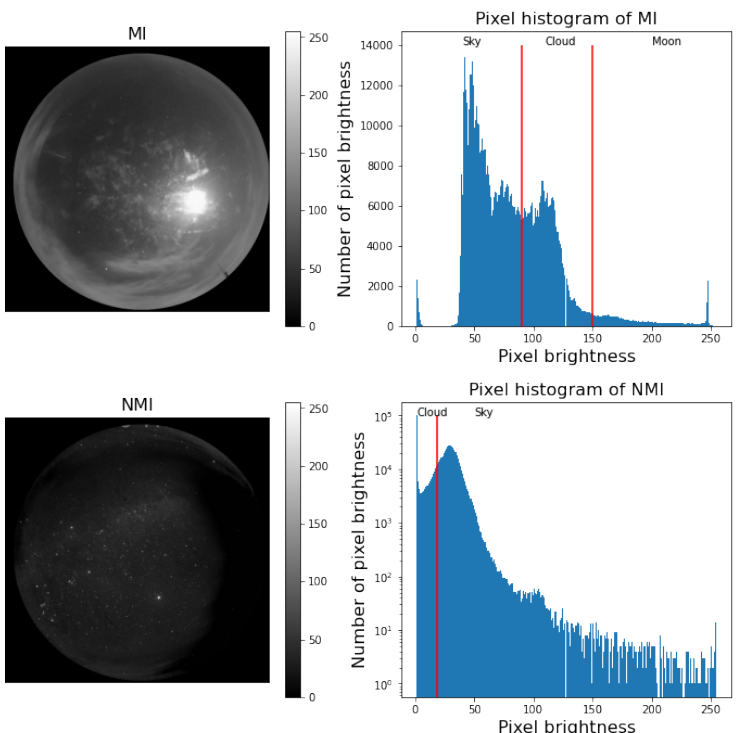
Figure 3. Two examples of all-sky images. Clouds (white) appear brighter than the clear sky in MI ( upper panel ) and clouds appear darker than the clear sky in NMI ( lower panel ). The histogram is presented in the right panels. The red line indicates the threshold value, which is obtained by our method in this